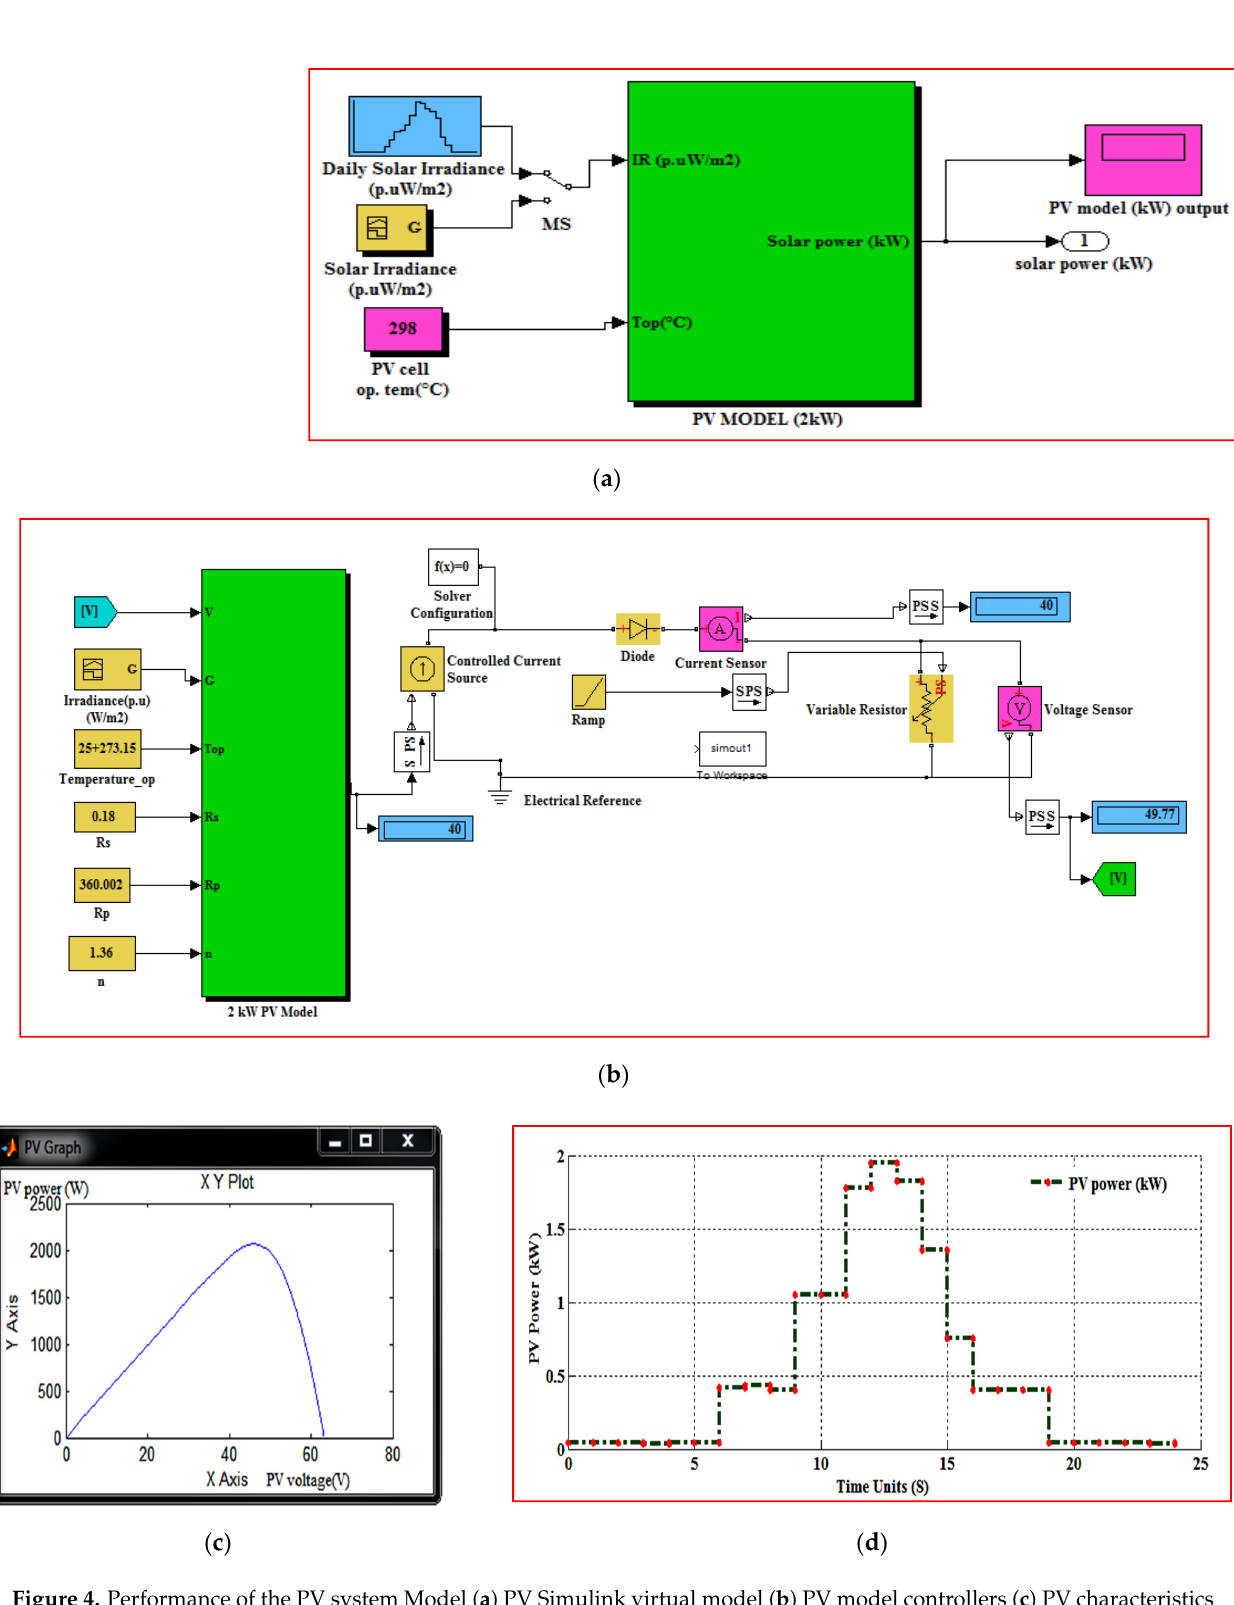
Figure 4. Performance of the PV system Model ( a ) PV Simulink virtual model ( b ) PV model controllers ( c ) PV characteristics in Simulink ( d ) PV power output.